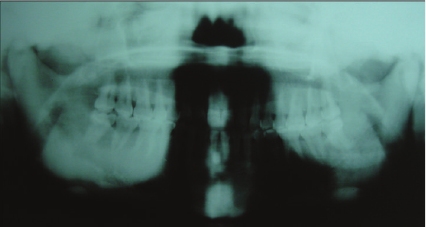
Figure 1: Panoramic radiograph showing signs of early periodonti- tis and sclerosis of the mandible and maxilla.